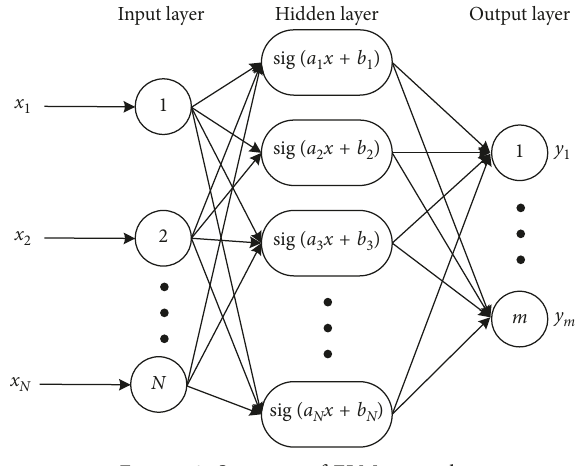
Figure 3: Structure of ELM network. Table 1: The four types of results of pear bruise